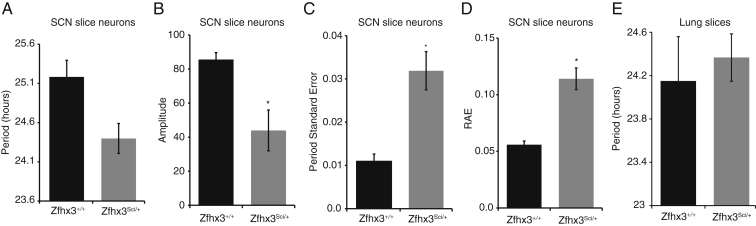
Disruption of PER2::LUC Rhythm in Individual Neurons In Ex Vivo SCN Slices, but Not in Ex Vivo Lung Slices, Related to Figure 1(A–D) The (A) period and (B) amplitude of fusion protein expression was decreased in individual neurons from Zfhx3Sci/+ ex vivo SCN slices compared to similar wild-type neurons. Furthermore, the (C) period distribution was broader, and (D) RAE increased in the Zfhx3Sci/+ neurons (p < 0.05, t test). There were no differences in period in organotypic lung slices (Figure S1E), suggesting these differences may be specific to the central oscillator.